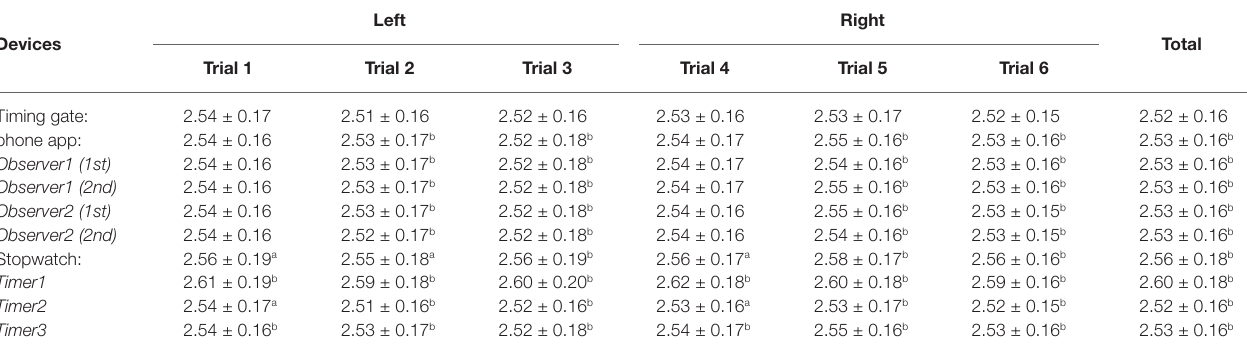
TABLE 1 | The average time obtained by timing devices, session, observers, and timers, from trial one to trial six in 505 COD test. Left Devices